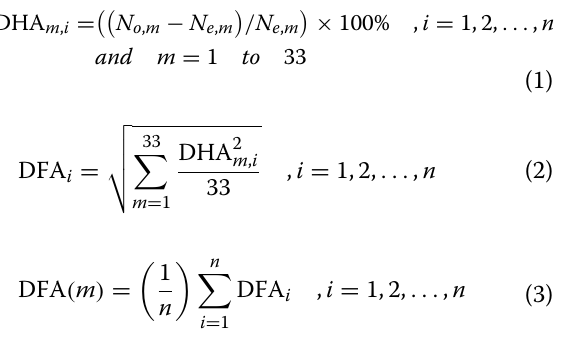
from the average) of the NFR (Richter et al. 1997).